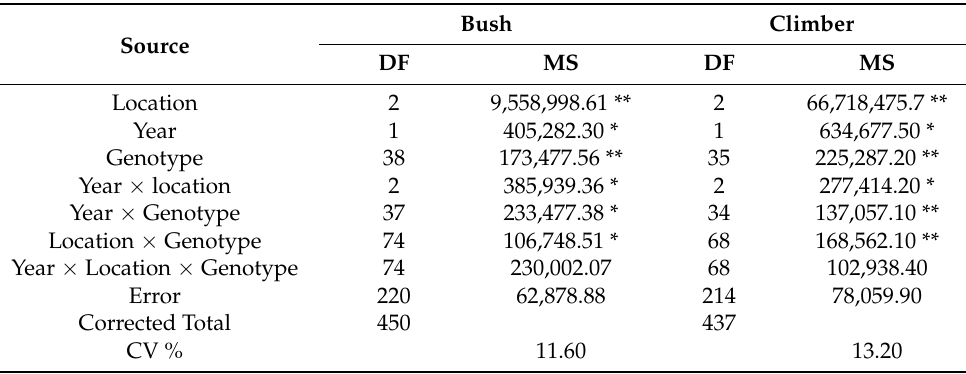
Table 6. Analysis of variance on the yield of bean genotypes tested in Rwanda.